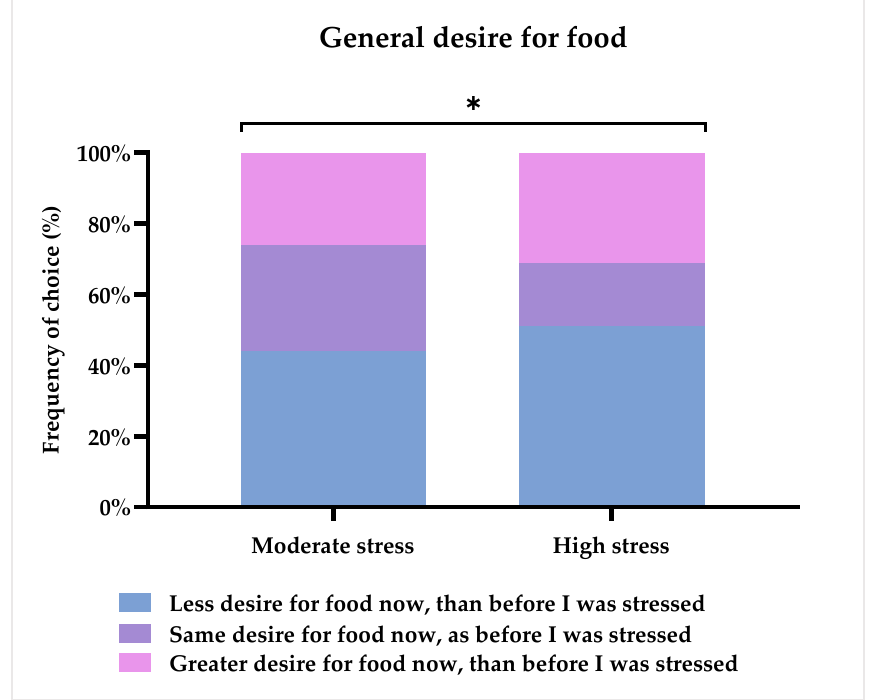
Figure 6. Subjective general desire for food as compared to before becoming ill with stress. Results are shown for the two groups based on the results of the PSS-10: ‘Moderate stress’ ( n = 116) and ‘High stress’ ( n = 74). Stars indicate level of significance of p -values. *: p < 0.05.